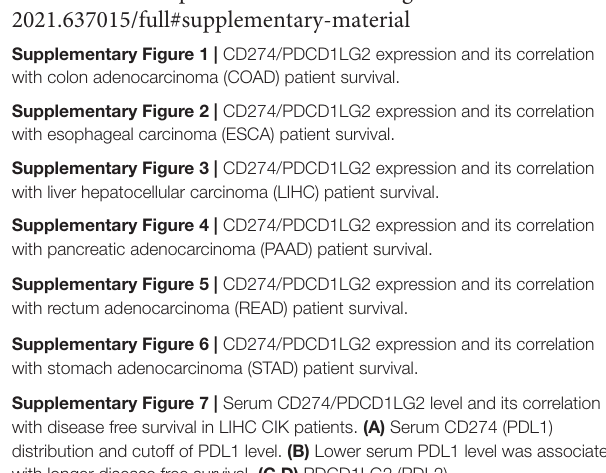
Supplementary Figure 1 | CD274/PDCD1LG2 expression and its correlation with colon adenocarcinoma (COAD) patient survival. Supplementary Figure 2 | CD274/PDCD1LG2 expression and its correlation with esophageal carcinoma (ESCA) patient survival. Supplementary Figure 3 | CD274/PDCD1LG2 expression and its correlation with liver hepatocellular carcinoma (LIHC) patient survival. Supplementary Figure 4 | CD274/PDCD1LG2 expression and its correlation with pancreatic adenocarcinoma (PAAD) patient survival. Supplementary Figure 5 | CD274/PDCD1LG2 expression and its correlation with rectum adenocarcinoma (READ) patient survival. Supplementary Figure 6 | CD274/PDCD1LG2 expression and its correlation with stomach adenocarcinoma (STAD) patient survival. Supplementary Figure 7 | Serum CD274/PDCD1LG2 level and its correlation with disease free survival in LIHC CIK patients. (A) Serum CD274 (PDL1) distribution and cutoff of PDL1 level. (B) Lower serum PDL1 level was associated with longer disease free survival. (C,D) PDCD1LG2